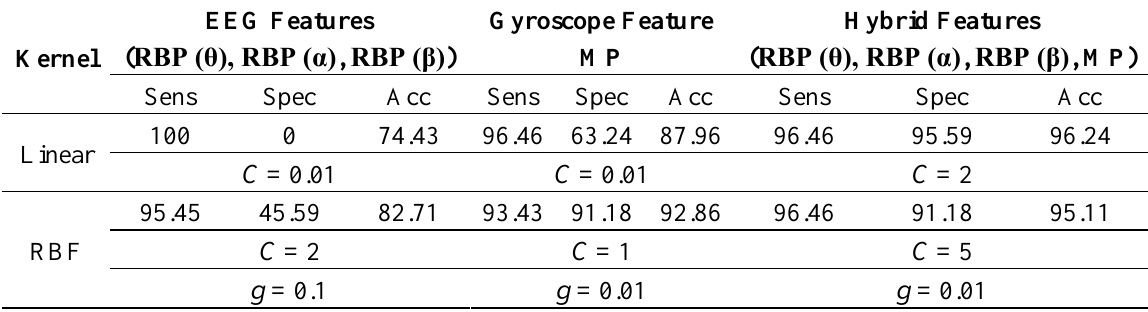
Table 1. Results of the leave-one-out (LOO) cross-validation experiments using EEG feature sets alone, gyroscope feature alone and the hybrid feature.